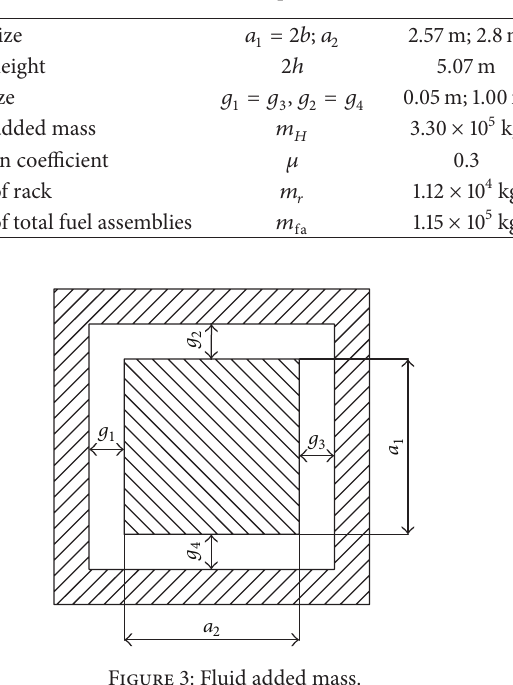
Table 2: Parameters of rack adopted in the simulation.